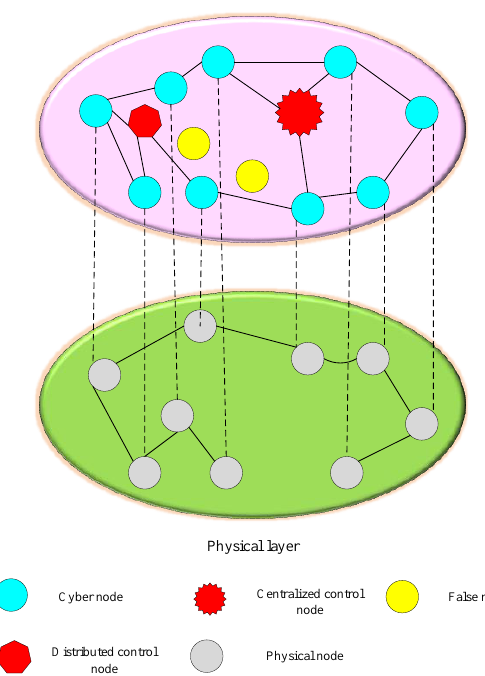
Figure 1. Cyber-physical power